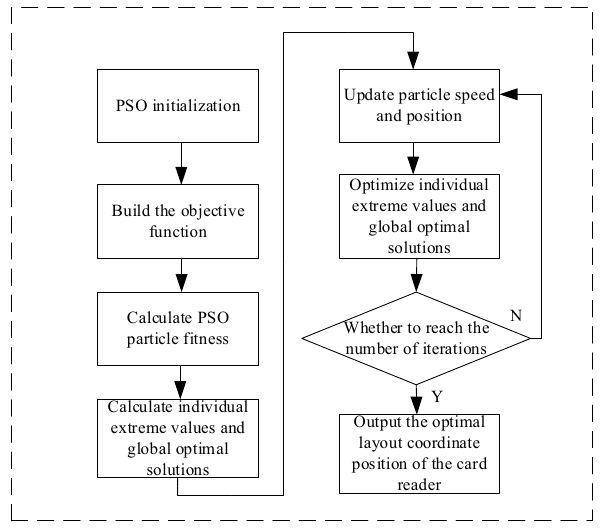
Figure 11. PSO optimizes the flow chart of reader position distribution.